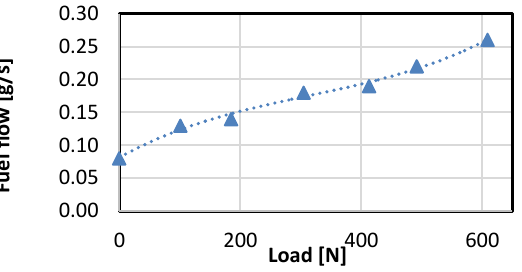
Fig. 14. Fuel flow as a function of engine load during operation in 1700